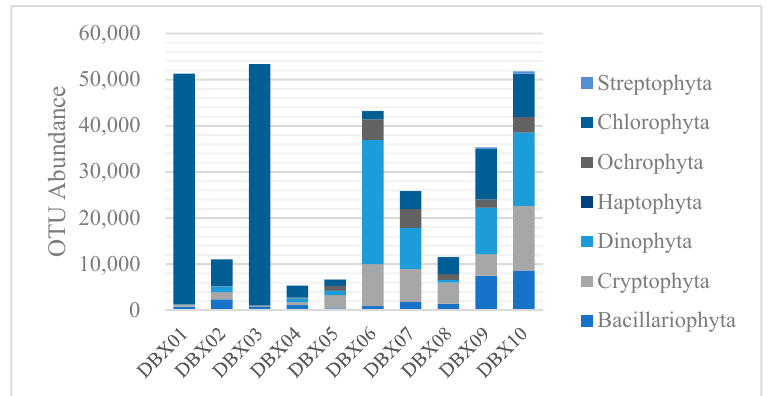
Figure 2. Each phylum’s proportion at each sample site in